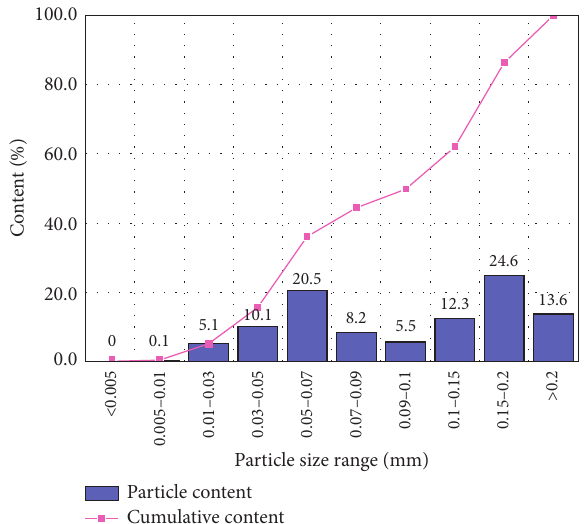
Figure 4: Particle size distribution of collophane